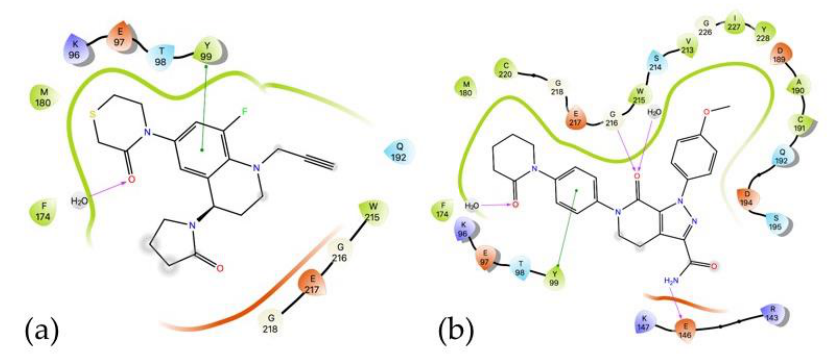
Figure 9. ( a ) Overlay of Apixaban (green) and compound 19 over active site of FXa. ( b ) Aniline derivative 8 on FXa.